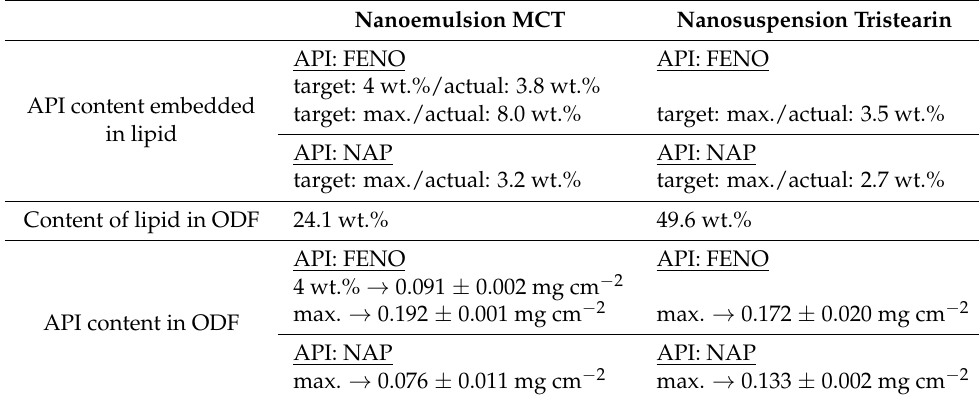
Table 2. API content embedded in lipid dispersions and total API content in an ODF with a surface weight of 10 mg cm − 3 , n =